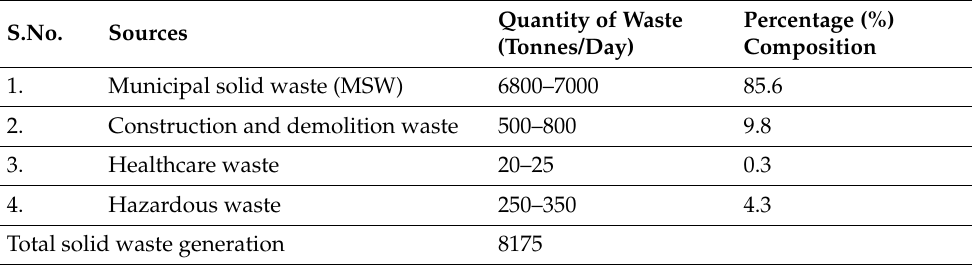
Table 1. Main sources of solid waste in Ho Chi Min City.